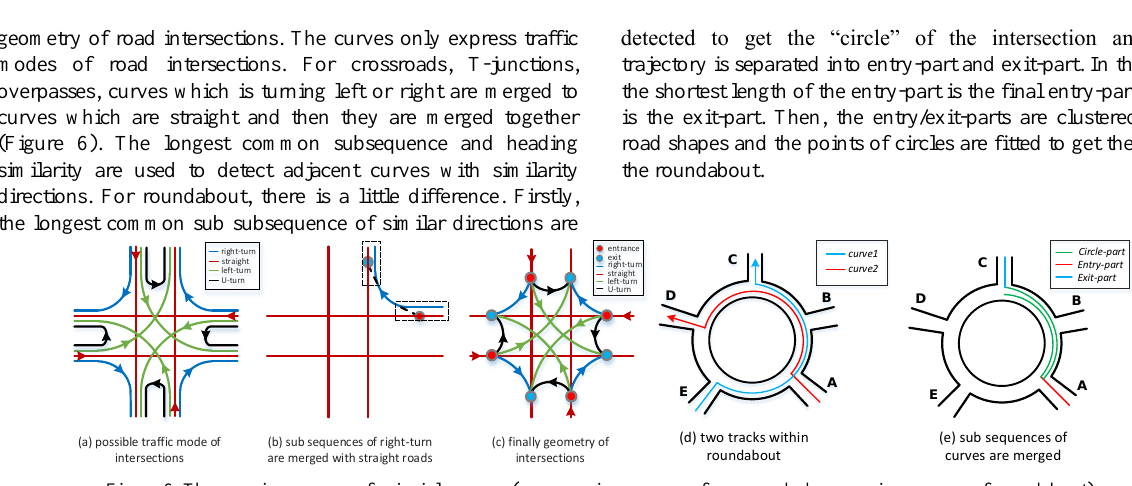
Figure 6. The merging process of principle curves (a-c: merging process of crossroad; d-e: merging process of roundabout)